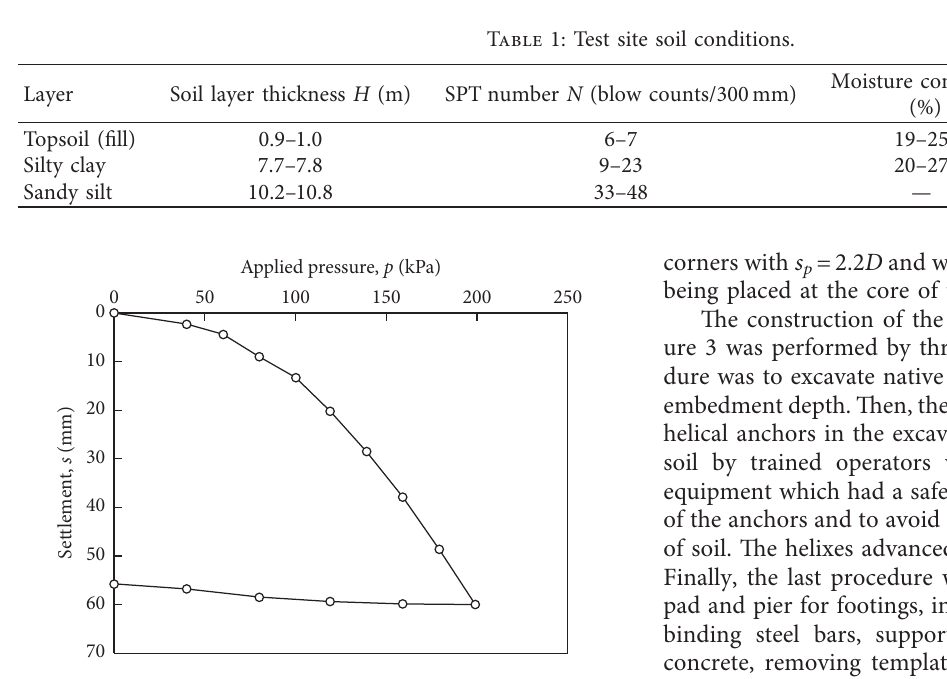
Figure 2: Load-settlement response in the plate loading test on silty clay at the depth of 1.5m.